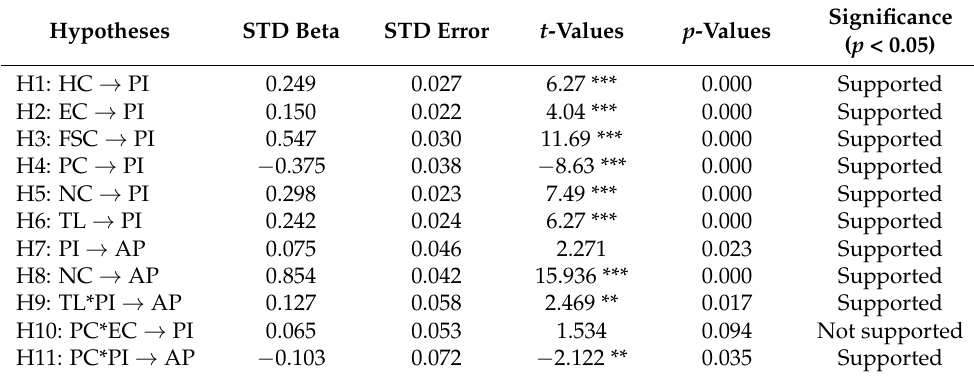
Table 4. Structural Model and Hypothesis Testing Result.